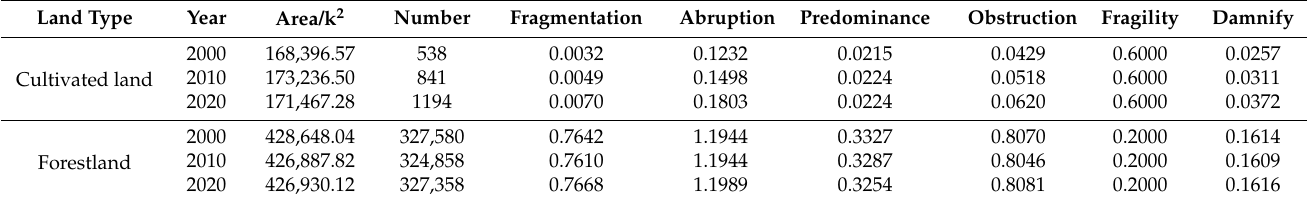
Table A4. Landscape pattern index of Dushanbe City from 2000 to